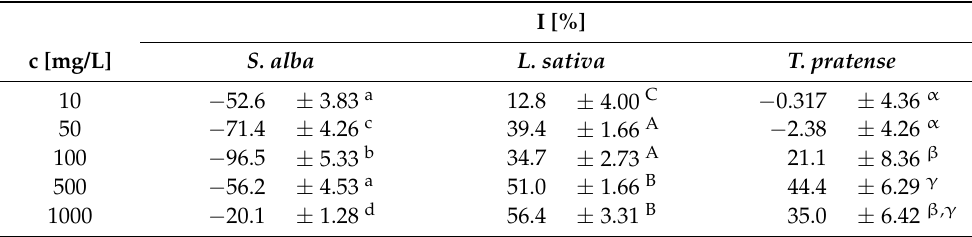
Table 3. The inhibition of root elongation content (calculated as a percentual inhibition of root growth compared to control) of white mustard ( Sinapis alba ), lettuce ( Lactuca sativa ) and clover ( Trifolium pratense ) after 3 days of seed germination in a solution supplemented with ZnO at concentrations of 10, 50, 100, 250, 500 and 1000 mg/L. Standard deviation is represented as ± S.D. ( n = 3), and two-way ANOVA test with Dunnett’s multiple comparisons was applied.